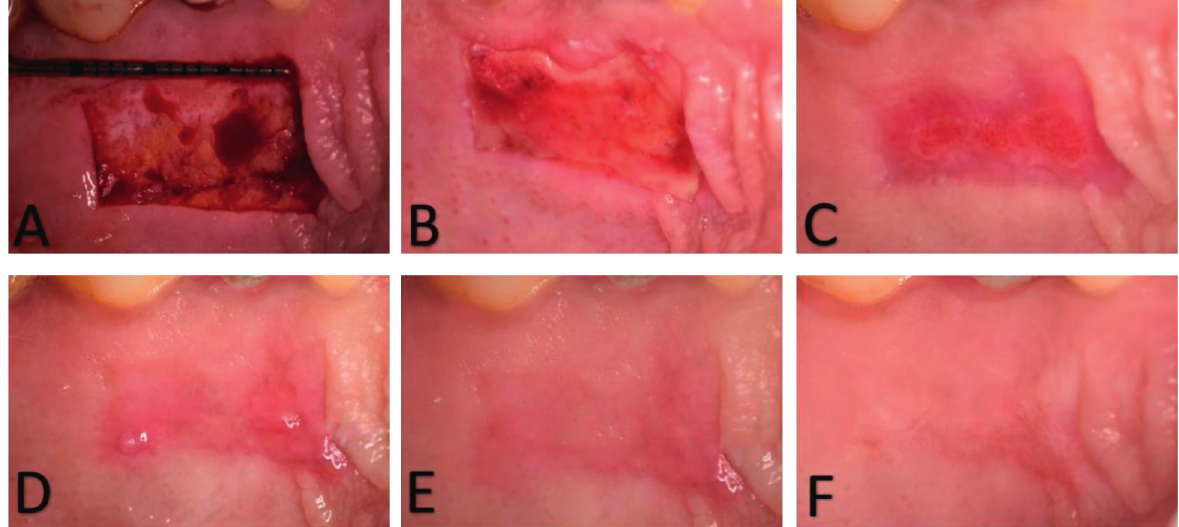
Figure 2: Clinical photographs showing palatal wound healing for the HA group: (a) day 0, (b) day 3, (c) day 7, (d) day 14, (e) day 21, and (f) day